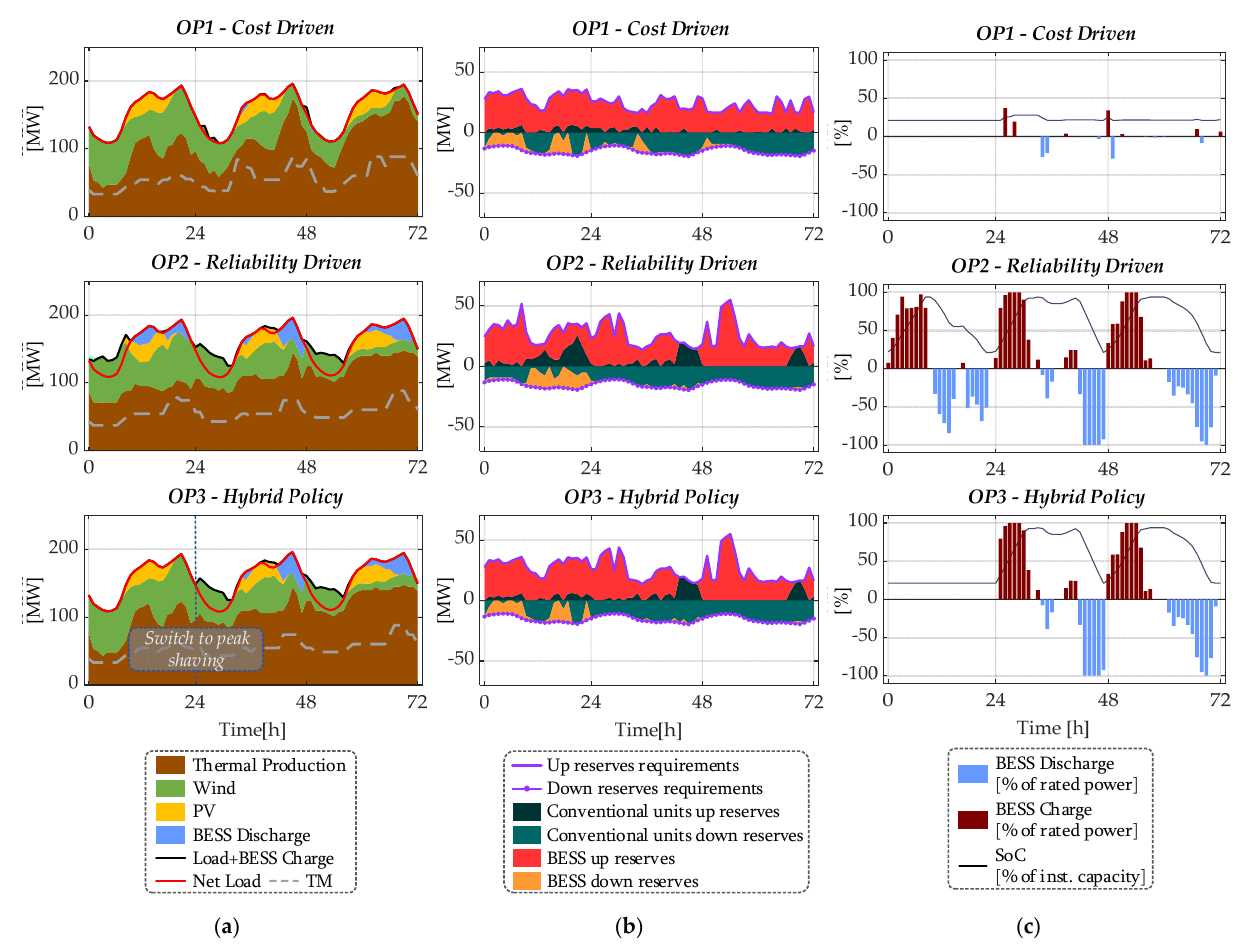
Figure 5. ( a ) Generation mix; ( b ) contribution of conventional units and BESS to system primary up/down reserves and ( c ) BESS operation over the same three-day period under the three OPs.